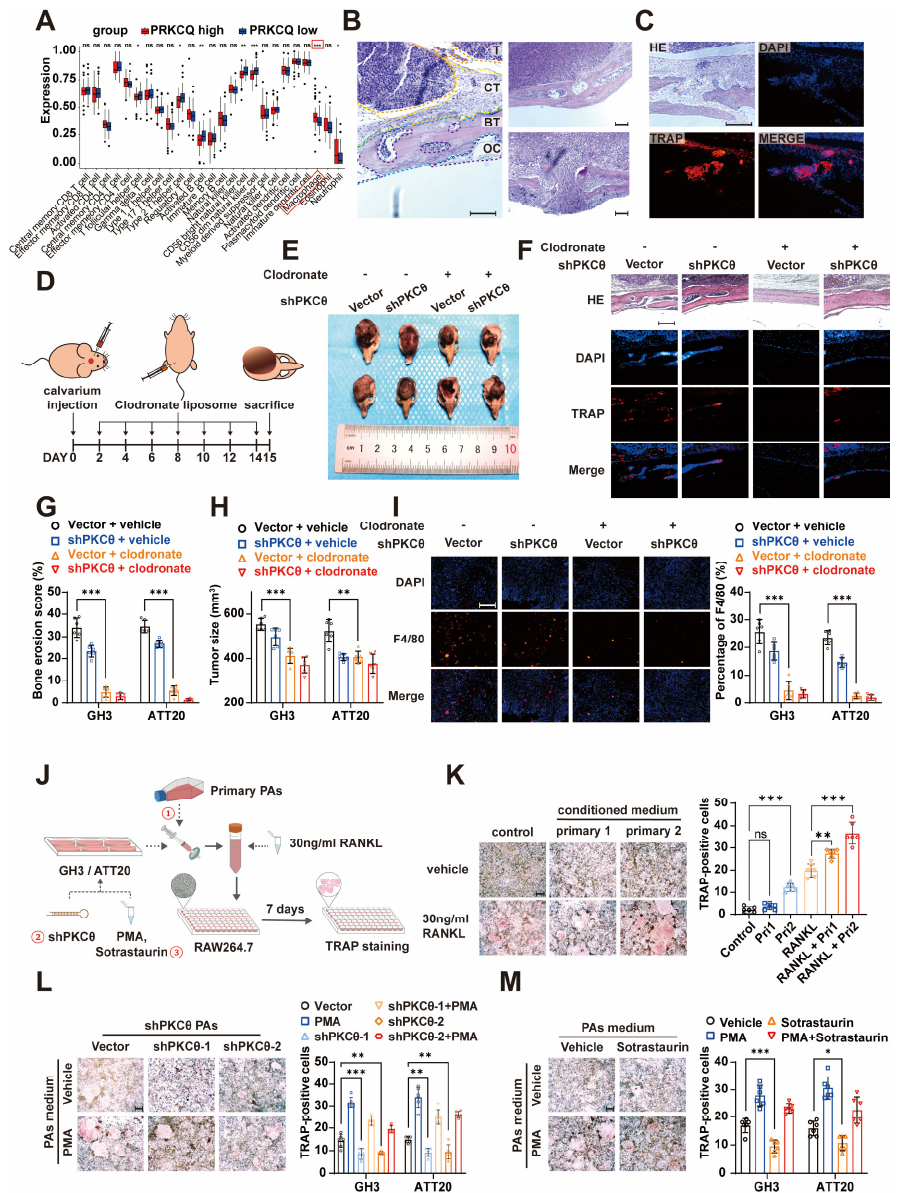
Figure 4. PAs induce monocyte–osteoclast differentiation via the paracrine pathway. ( A ) Immune infiltration analysis; PRKCQ high expression group versus PRKCQ low expression group (the data analyzed are described in Figure 2A; *** p < 0.001; ** p < 0.01; * p < 0.05; NS p ≥ 0.05). ( B ) HE staining exhibited the local environment of tumor–bone junction area (×100; scale bar, 200 µm; T, tumor; CT, connective tissue; BT, bone tissue; OC, osteoclast). ( C ) Immunofluorescence of TRAP+ cells in the tumor–bone junction area (×200; scale bar, 100 µm). ( D ) Schematic diagram of calvaria xenograft PA in nude mice and clodronate liposome administration. ( E , H ) Photographs of GH3 calvaria xenograft tumor specimens in treatment of clodronate liposomes and shPKCθ ( E ). Quantification of tumor